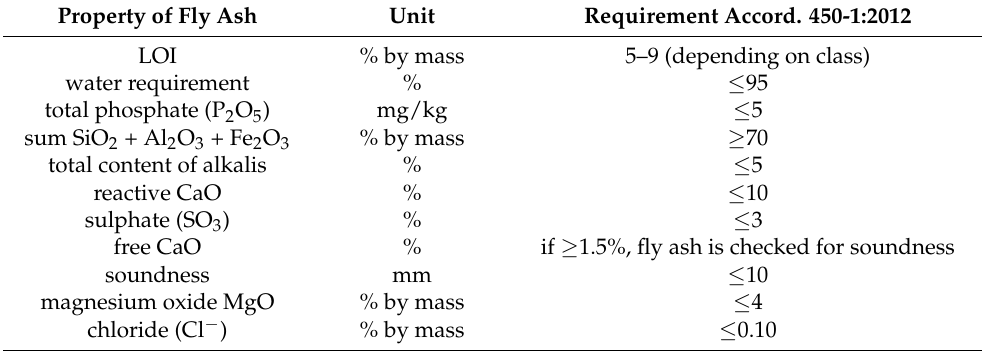
Table 1. Chosen requirements for fly ash according to the EN 450-1:2013. LOI—lost on ignition. Property of Fly Ash Unit Requirement Accord. 450-1:2012